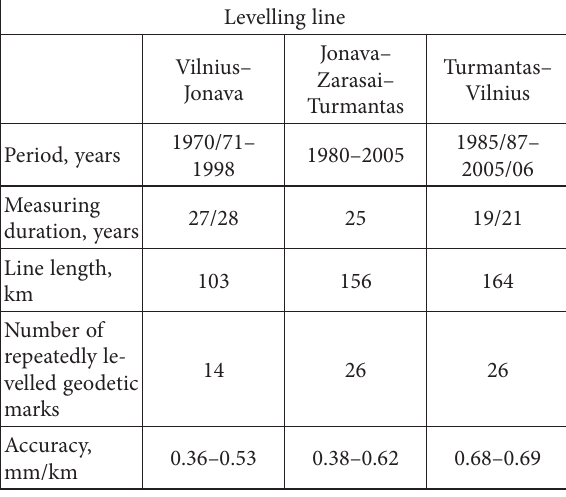
Table 1. Characteristics of the levelling